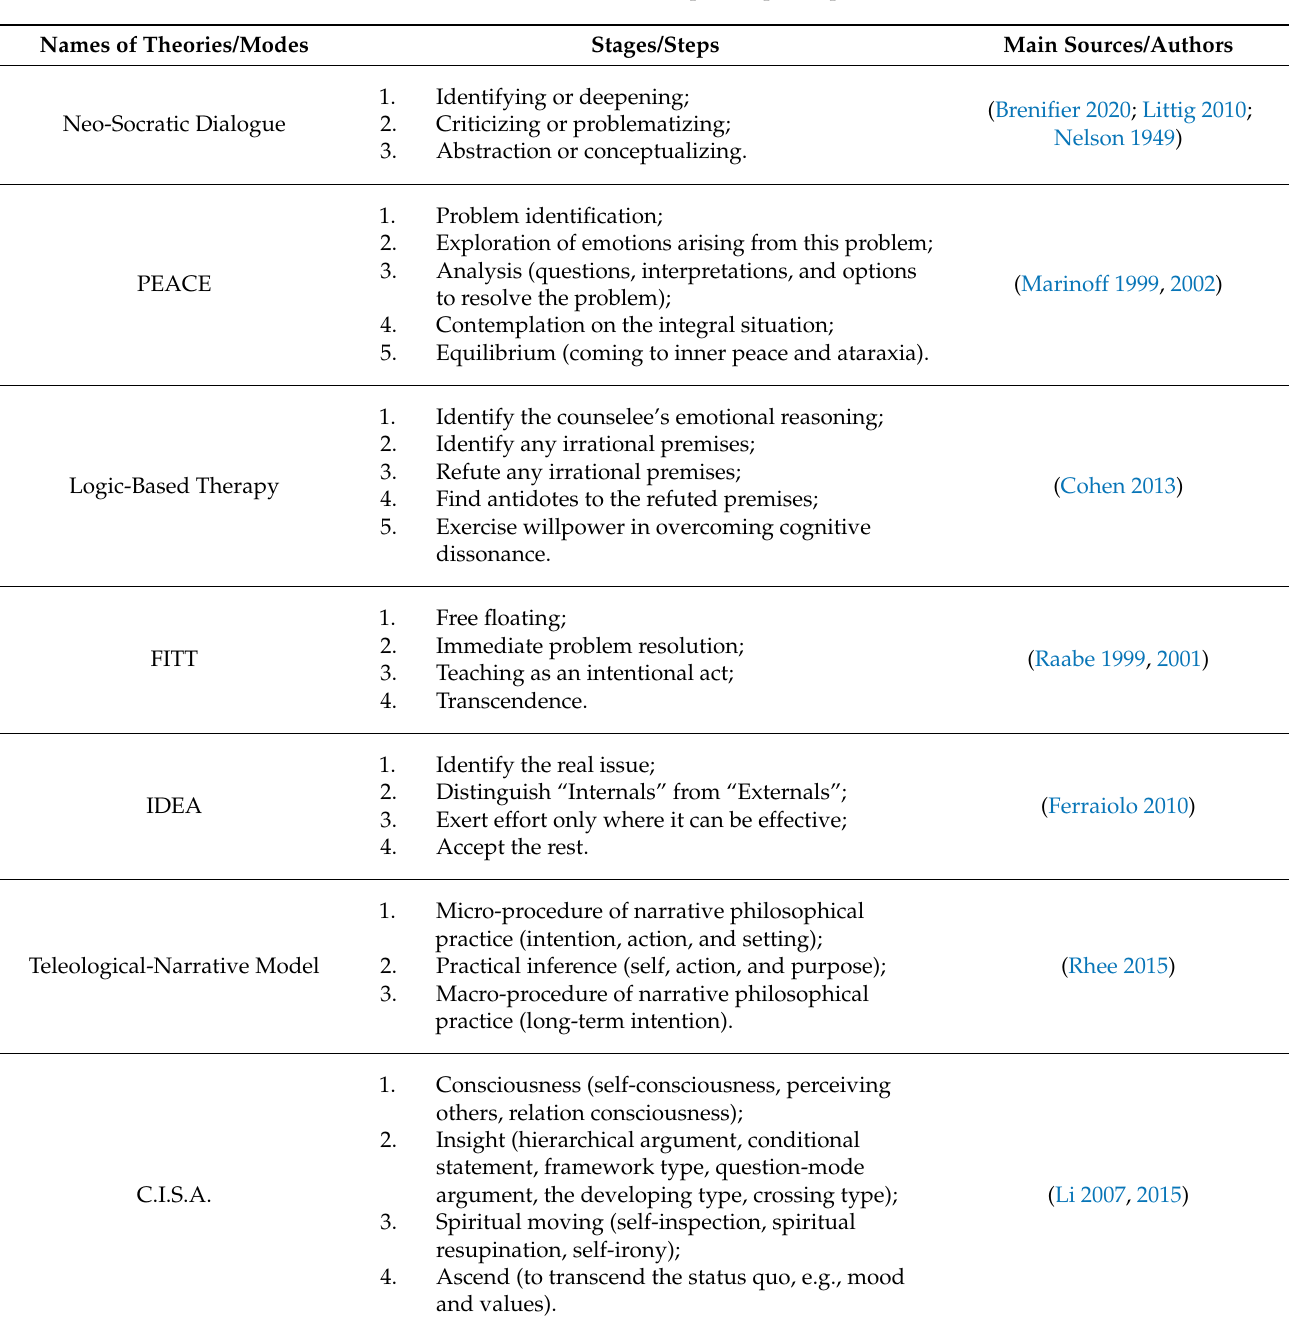
Table 1. Dominant theories/modes in philosophical